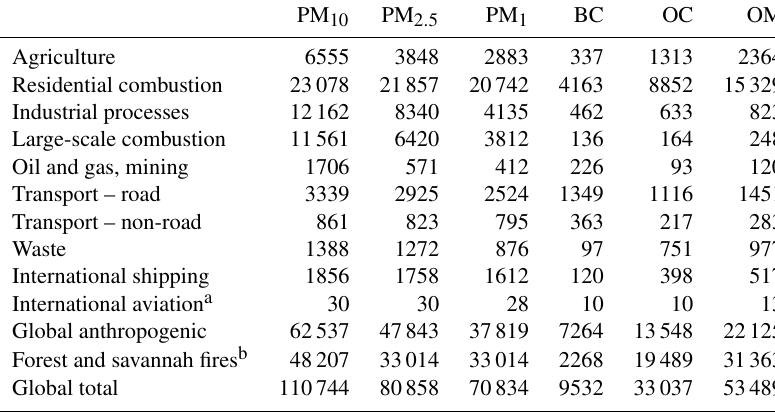
Table 8. Sectoral emissions of particulate matter in 2010, ECLIPSE V5a , Ggyear − 1